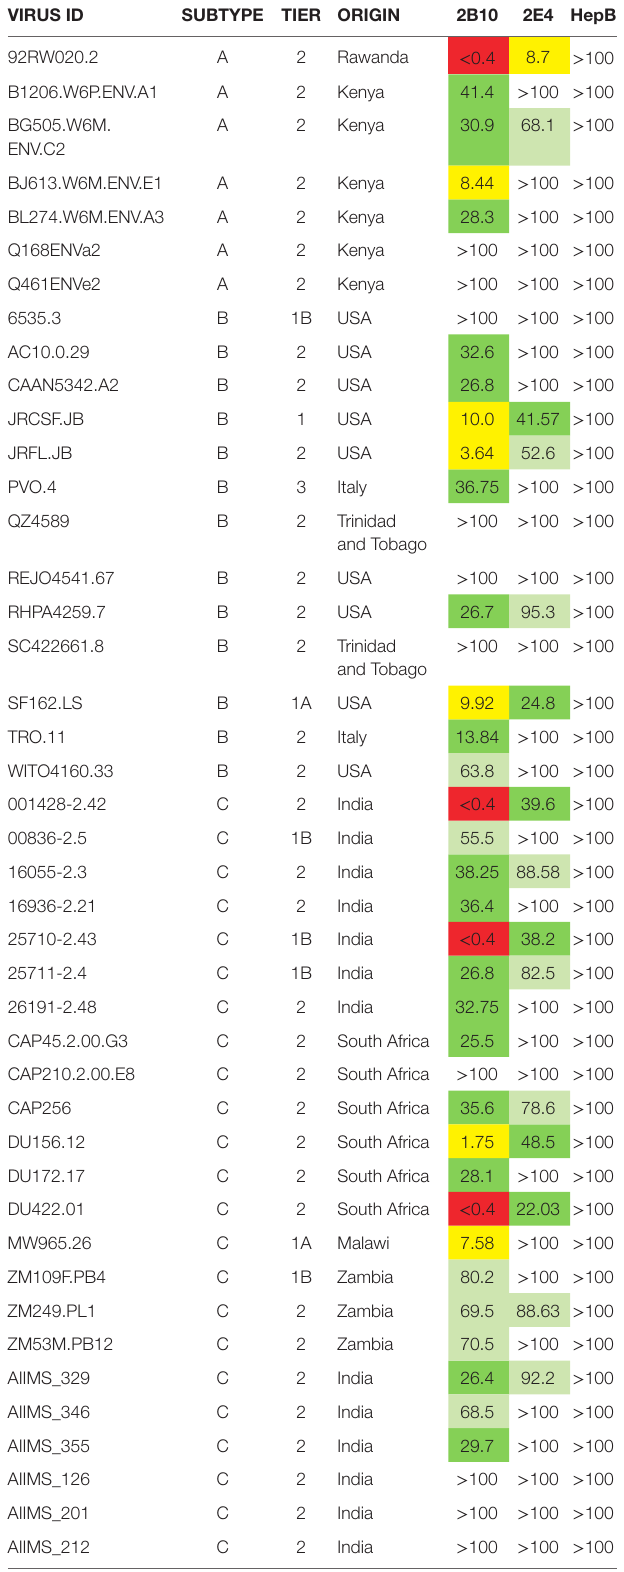
TaBle 5 | Neutralization profile of anti-CD4bs scFv monoclonals 2B10 and 2E4. VirUs